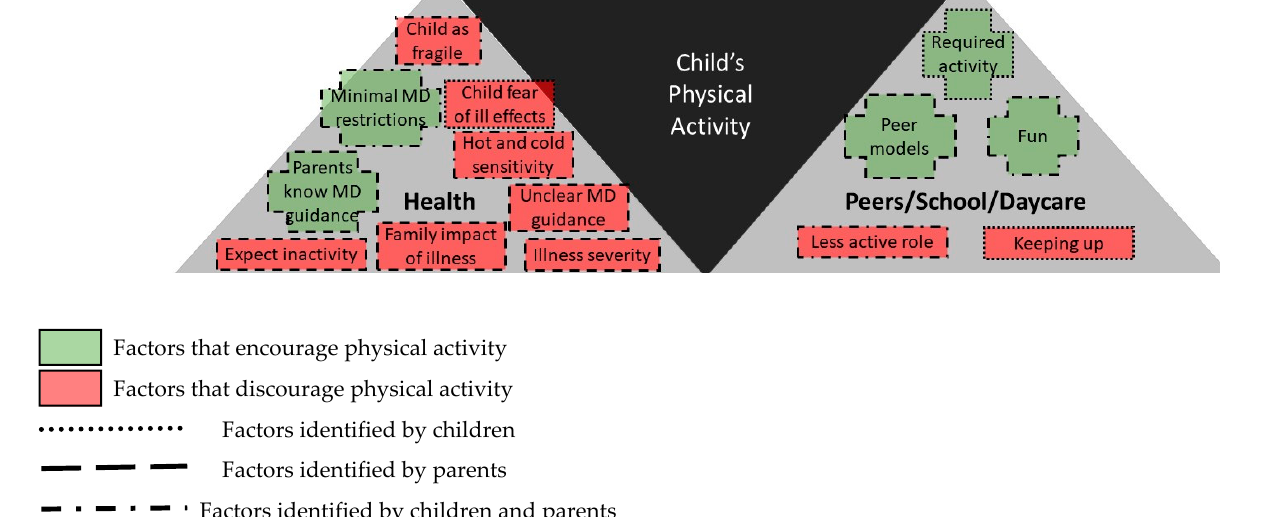
Figure 1. Situational Map of Environments Impacting on the Physical Activity of Children with Complex Congenital Heart Disease.